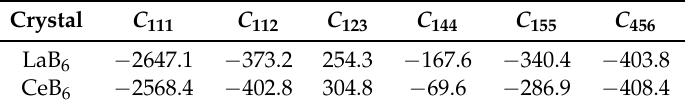
Table 3. Third-order elastic constants C ijk (in GPa) of LaB 6 and CeB 6 . Crystal